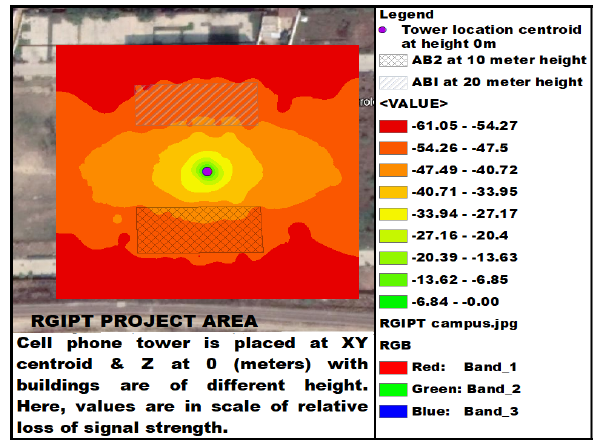
Figure 21. Cell phone tower at XY Centroid and Z at 0 meters when both building heights are different.